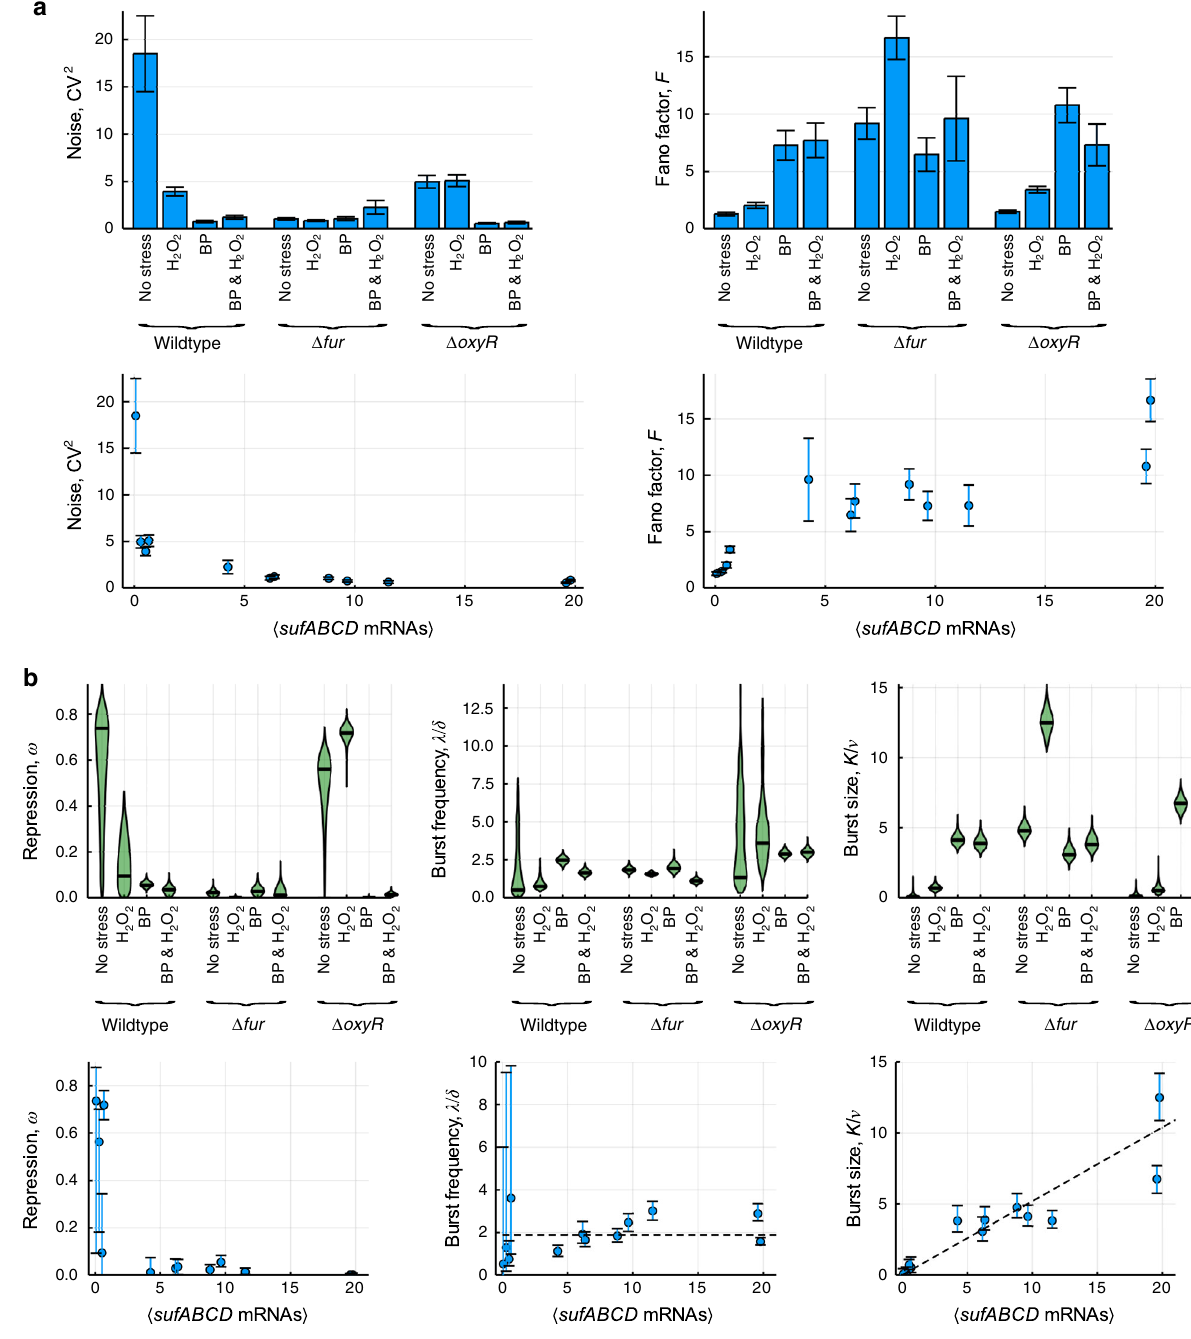
Fig. 4 Transcriptional noise and bursting of the σ 70 controlled Suf system. Wildtype, Δ fur and Δ oxyR E. coli cells were grown in absence (no stress) and in presence of either H 2 O 2 , BP or BP + H 2 O 2 . The cells were then subjected to RNA fl uorescence in situ hybridization with probes against sufABCD mRNA 30 . a Noise (CV 2 = σ 2 / μ 2 ) and burstiness (Fano factor F = σ 2 / μ ) of sufABCD transcription under each condition (top) and as a function of the mean sufABCD mRNAs per cell (bottom). CV 2 and F were calculated from the mean and standard deviations associated with the mRNA distributions in Supplementary Fig. 6. Data are presented as the statistic of the full set of data samples + / − the SEM obtained from n = 10,000 bootstrap resamples. b Burst kinetics of sufABCD transcription under each condition (top) and as a function of the mean sufABCD mRNAs per cell (bottom). Data are presented as the maximum a posteriori estimate (measure of centre of the error bar) and error bars are 95% credible intervals. Both are derived from the MCMC posterior